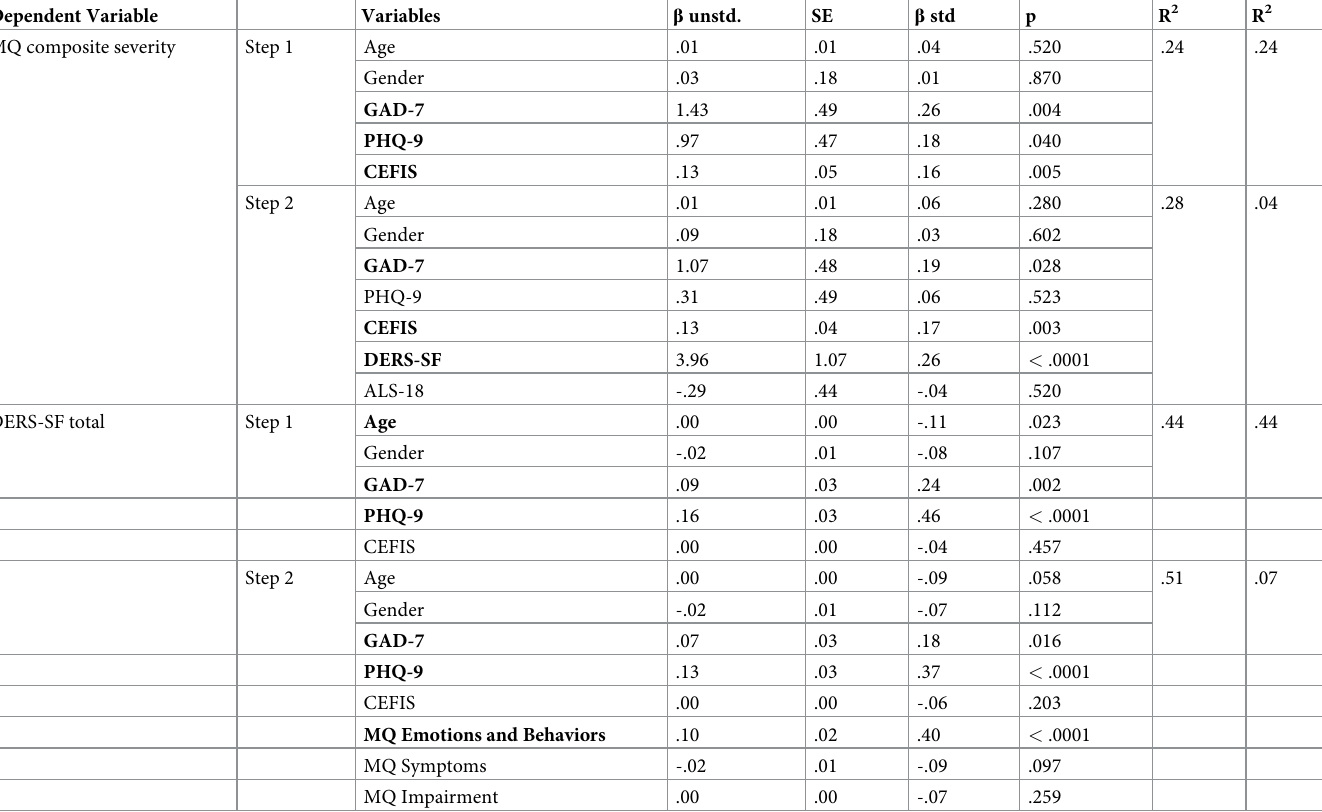
Table 3. Multiple linear regressions examining emotional functioning in